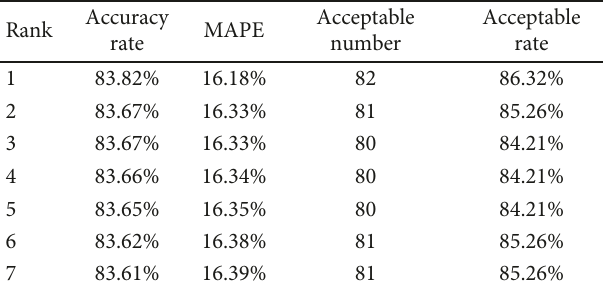
Table 6: Life prediction results for the fi rst seven optimal parameters.